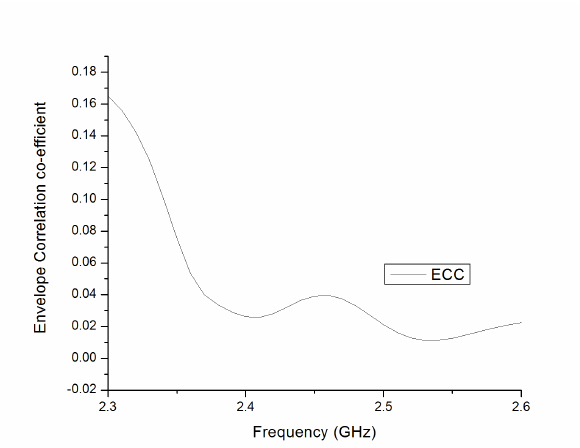
Figure 8: Simulated envelope correlation co-efficient